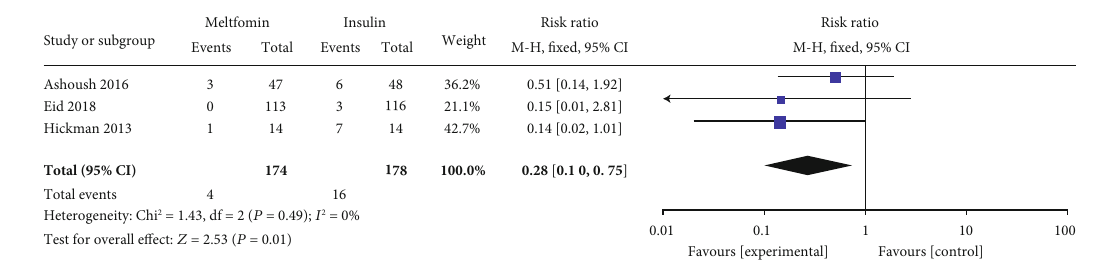
Figure 4: HbA1c% at